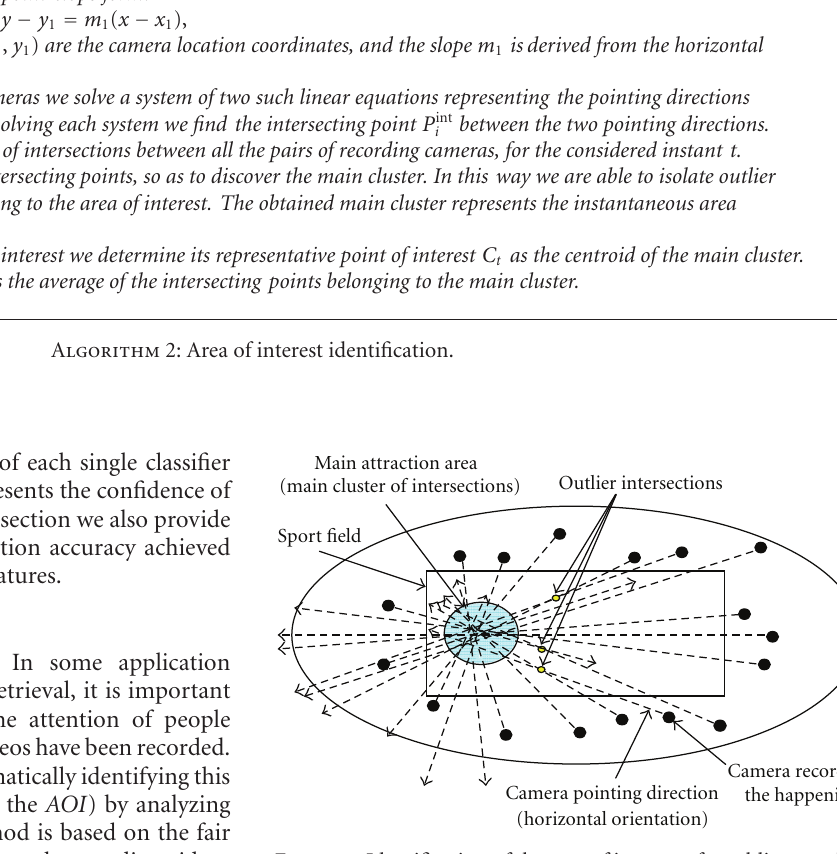
Figure 7: Identification of the area of interest of a public event held in a stadium (view from the